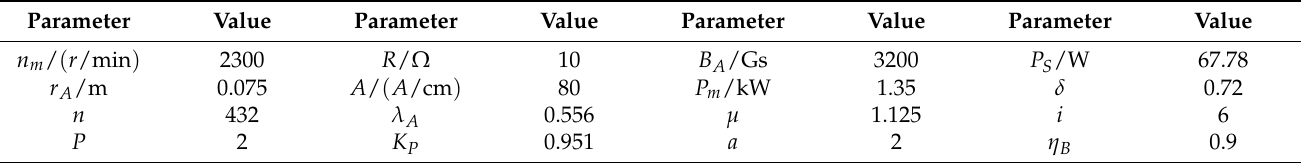
Table 3. The parameters of